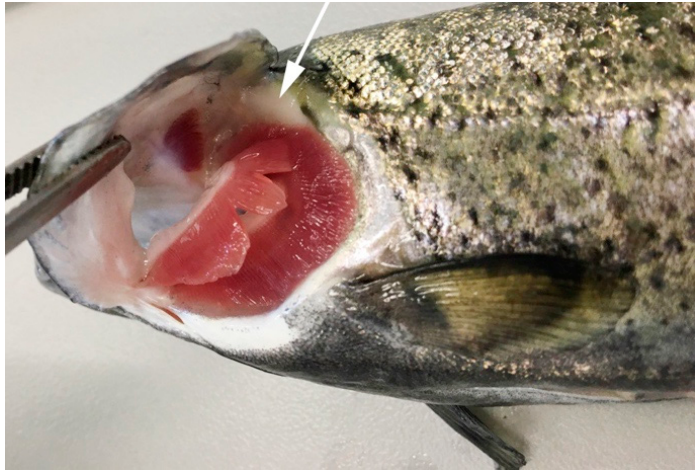
Figure 1 . Thymus location in rainbow trout ( Oncorhynchus mykiss ). View of the branchial cavity of a 72 g rainbow trout showing the dorsal location of the thymus (arrow).